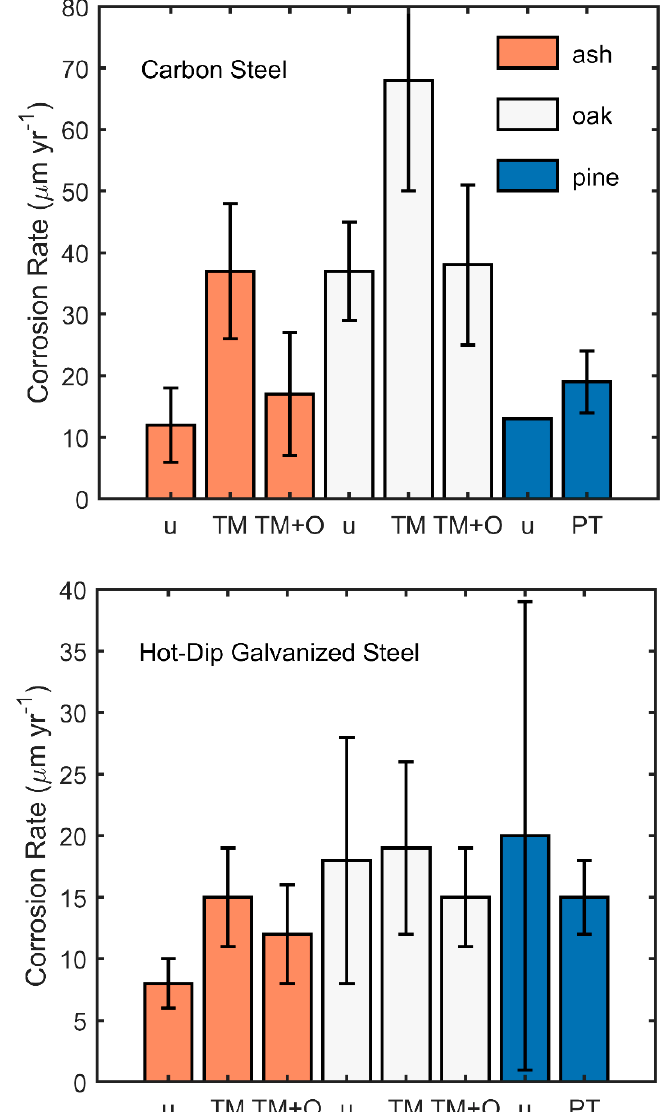
Figure 1. Corrosion rates measured for hot-dip galvanized and plain carbon steel fasteners in ash, oak, and pine. Legend: u = untreated, TM = Thermally Modified, TM + O = Thermally Modified with Oil treatment, PT = Preservative Treatment. The error bars represent the standard deviation. Note the different y -axis scales.